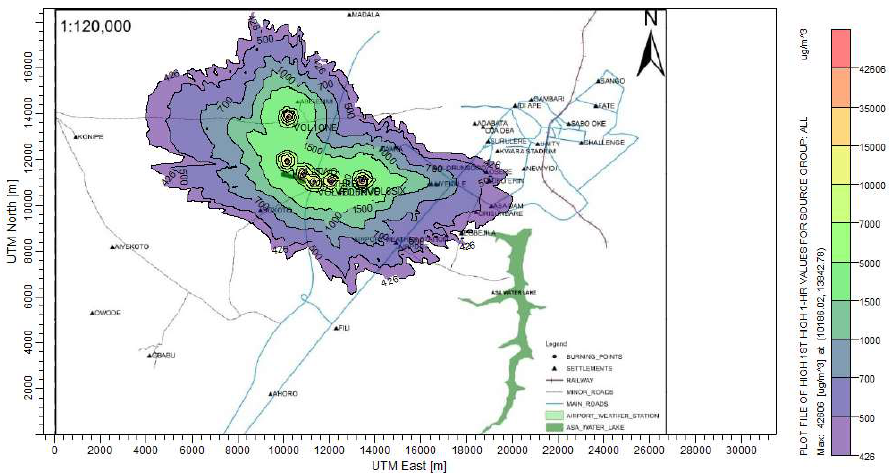
Figure 10. Isopleth of 1-h ground level SO x from Sokoto-Aiyekale dump site.